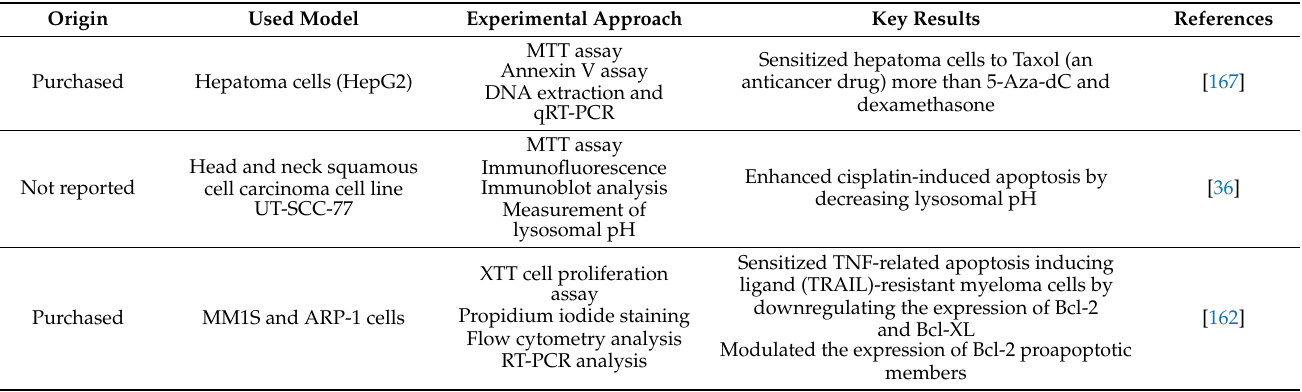
Table 5. Anticancer activity of TSA through